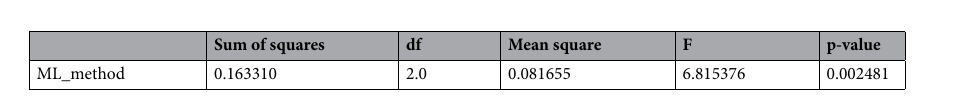
Table 5. Results of ANOVA comparison between ML method results.